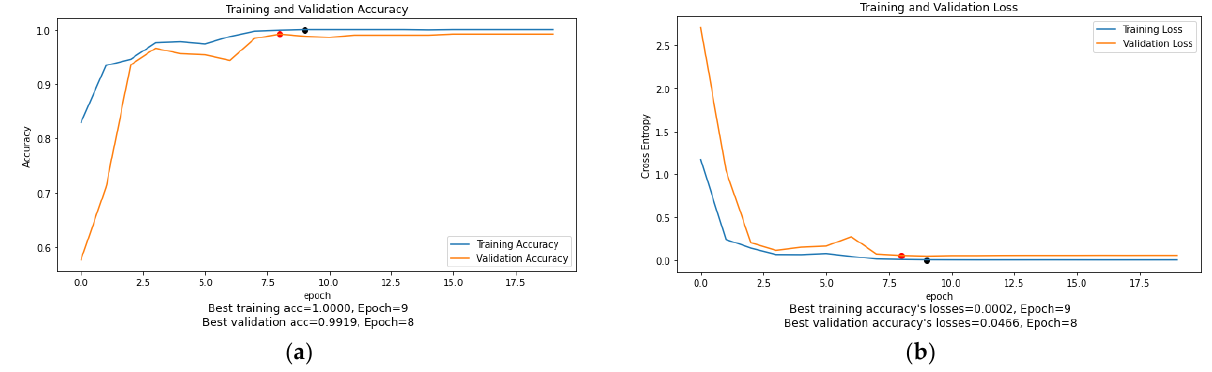
Figure 10. ( a ) Accuracy and ( b ) loss plots throughout the training process of the InceptionV3 model using the GRAY+GRAY_HE+GRAY_CLAHE image representation.